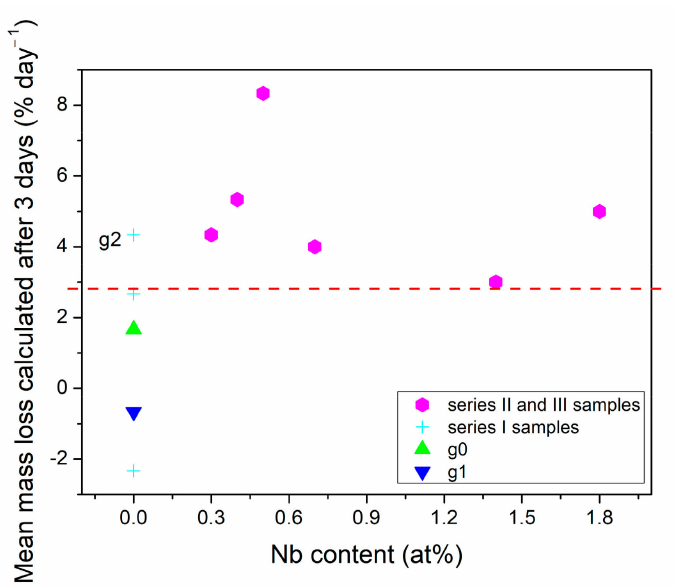
Figure 7. The effect of niobate addition on mean % mass loss calculated per day, during the early steps of the reaction (first 3 days of